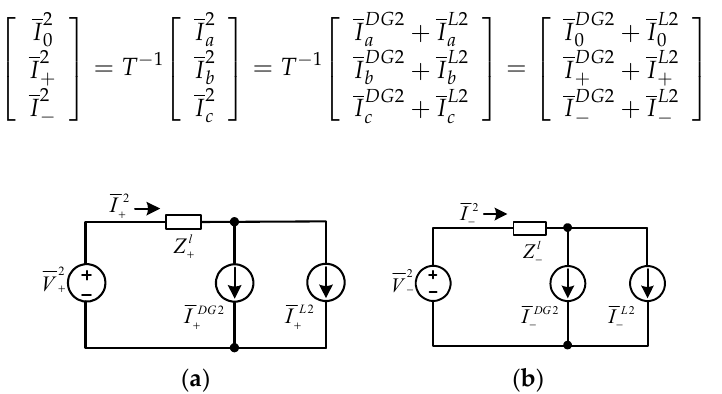
Figure 3. Sequence circuit models of Figure 2. ( a ) Positive sequence; ( b ) negative sequence.